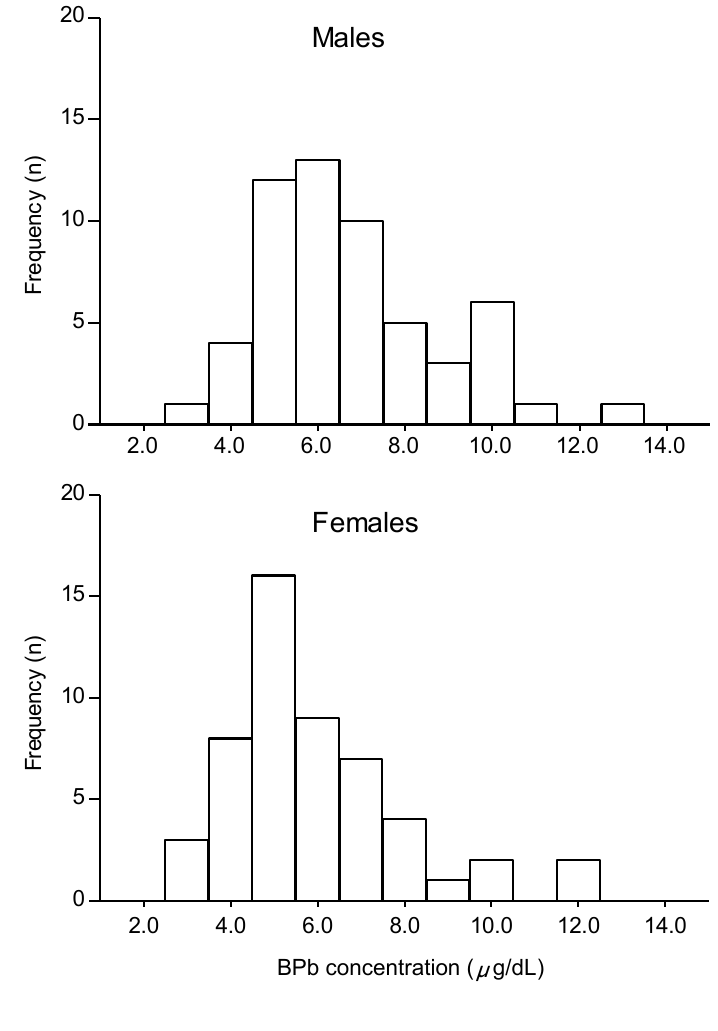
Figure 1. Distribution of blood lead (BPb) concentrations in 6–7-year-old children (n = 108, 56 male, 52 female) in Serpong, Banten,